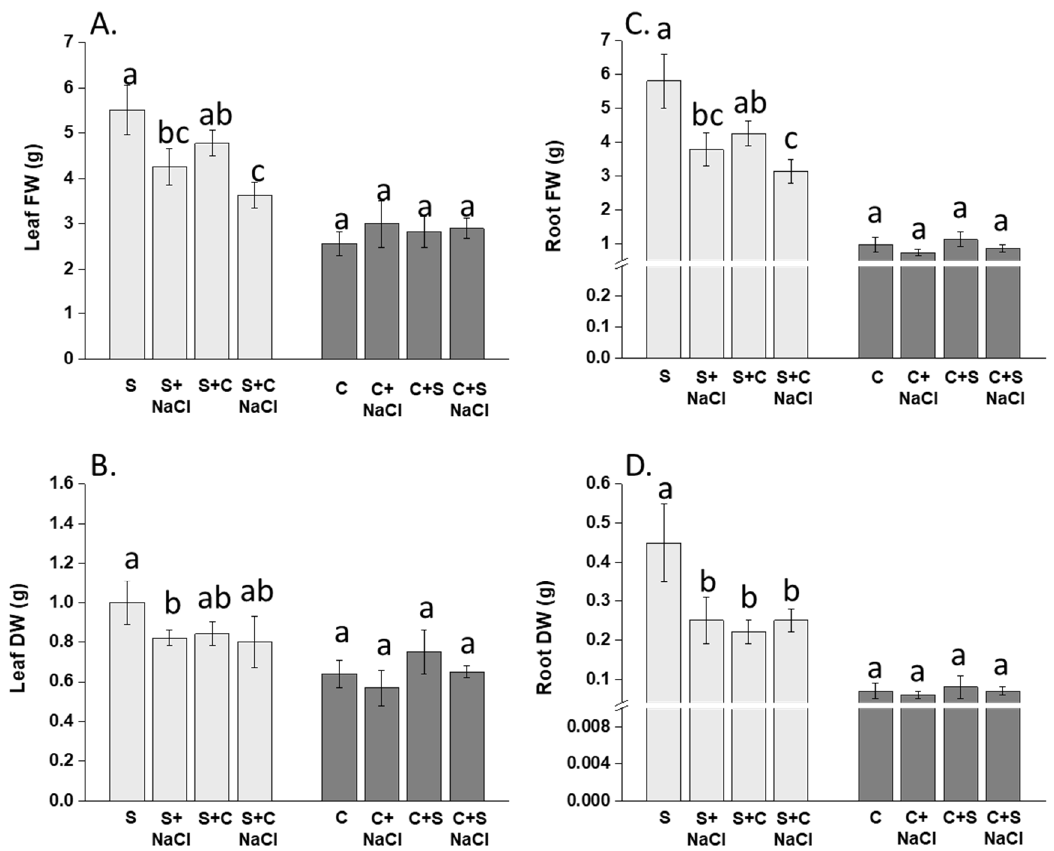
Figure 2. ( A ) Leaf fresh weight (FW) of soybean and C. album , treated and nontreated with NaCl. ( B ) Leaf dry weight (DW) of soybean and C. album , treated and nontreated with NaCl. ( C ) Root fresh weight (FW) of soybean and C. album treated and nontreated with NaCl. ( D ) Root dry weight (DW) of soybean and C. album , treated and nontreated with NaCl. Different letters within each group of bars indicate significant differences at p < 0.05, n = 6. S = soybean; C = C. album. The experiment was replicated twice, and only data from one representative experiment are shown.